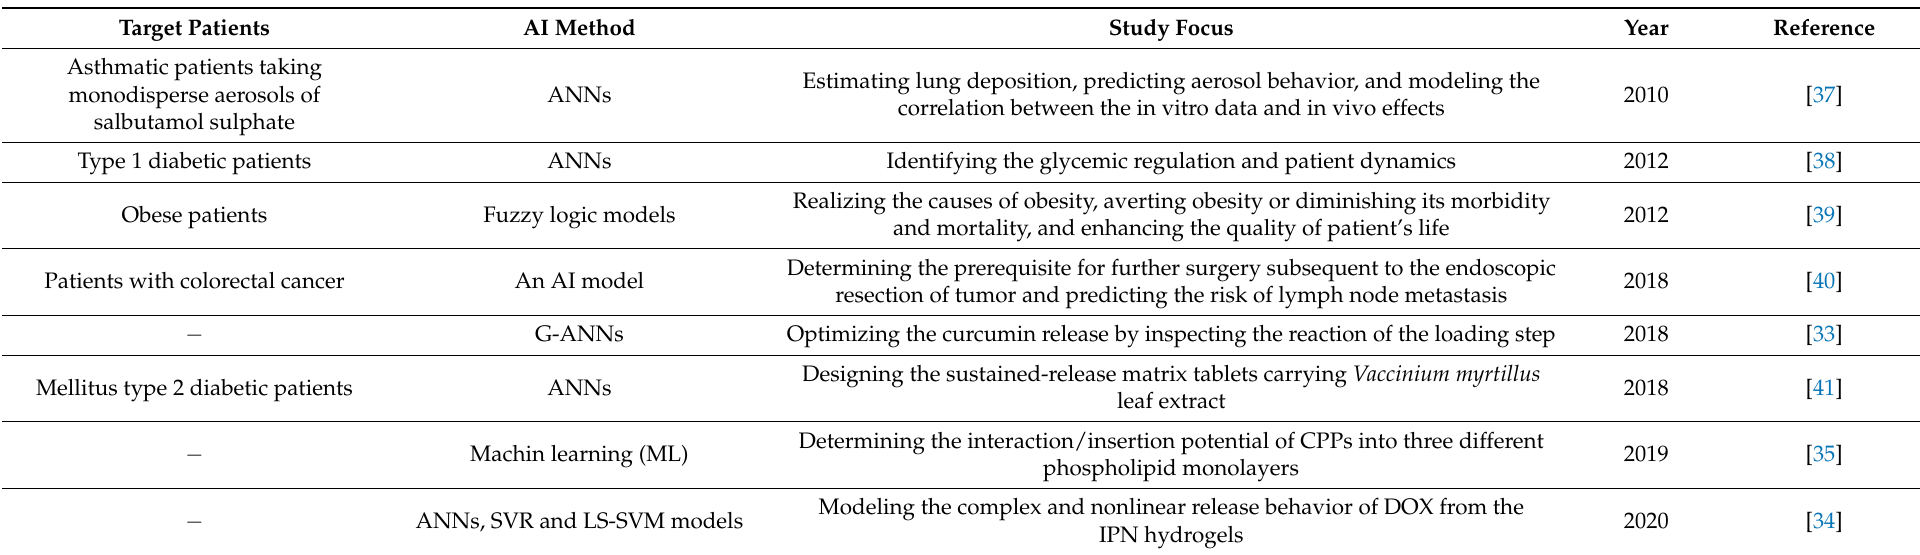
Table 2. A summary of some studies utilizing AI methods for drug